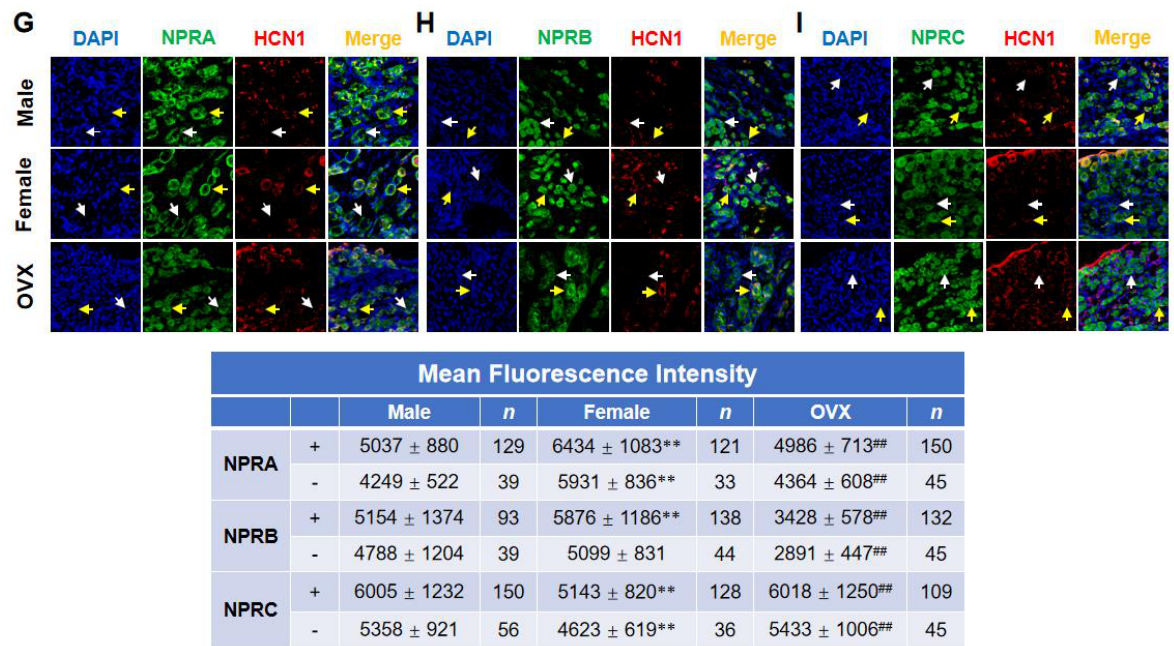
Figure 2. Gender-related differential expression of natriuretic peptide receptors (NPRs) in the nodose ganglia (NG) and nucleus tractus solitarius (NTS). ( A – C ) mRNA and protein expression of NPRs in NG of adult male, age-matched female, and OVX rats. * p < 0.05, ** p < 0.01 vs. male rats, # p < 0.05, ## p < 0.01 vs. female rats, n = 5. ( D – F ) mRNA and protein expression of NPRs in NTS of adult male, age-matched female and OVX rats. * p < 0.05, ** p < 0.01 vs. male rats, # p < 0.05, ## p < 0.01 vs. female rats, n = 5. ( G − I ) Representative immunostaining for NPRA, NPRB, and NPRC; the hyperpolarization-activated channel specifically expressed on myelinated afferents (HCN1 − posi- tive) and neurons were labeled by the antibodies against DAPI (blue), HCN1 (red), and NPRs (green). The yellow arrows pointed to HCN1 positive cells, and the white arrows pointed to HCN1 negative cells. Magnification power was 200×. The bottom table: Quantization results of immuno- histochemical staining of NPRs. Data was shown as mean ± SD. ** p < 0.01 vs. male rats, ## p < 0.01 vs. female rats, from 4 − 5 slices.